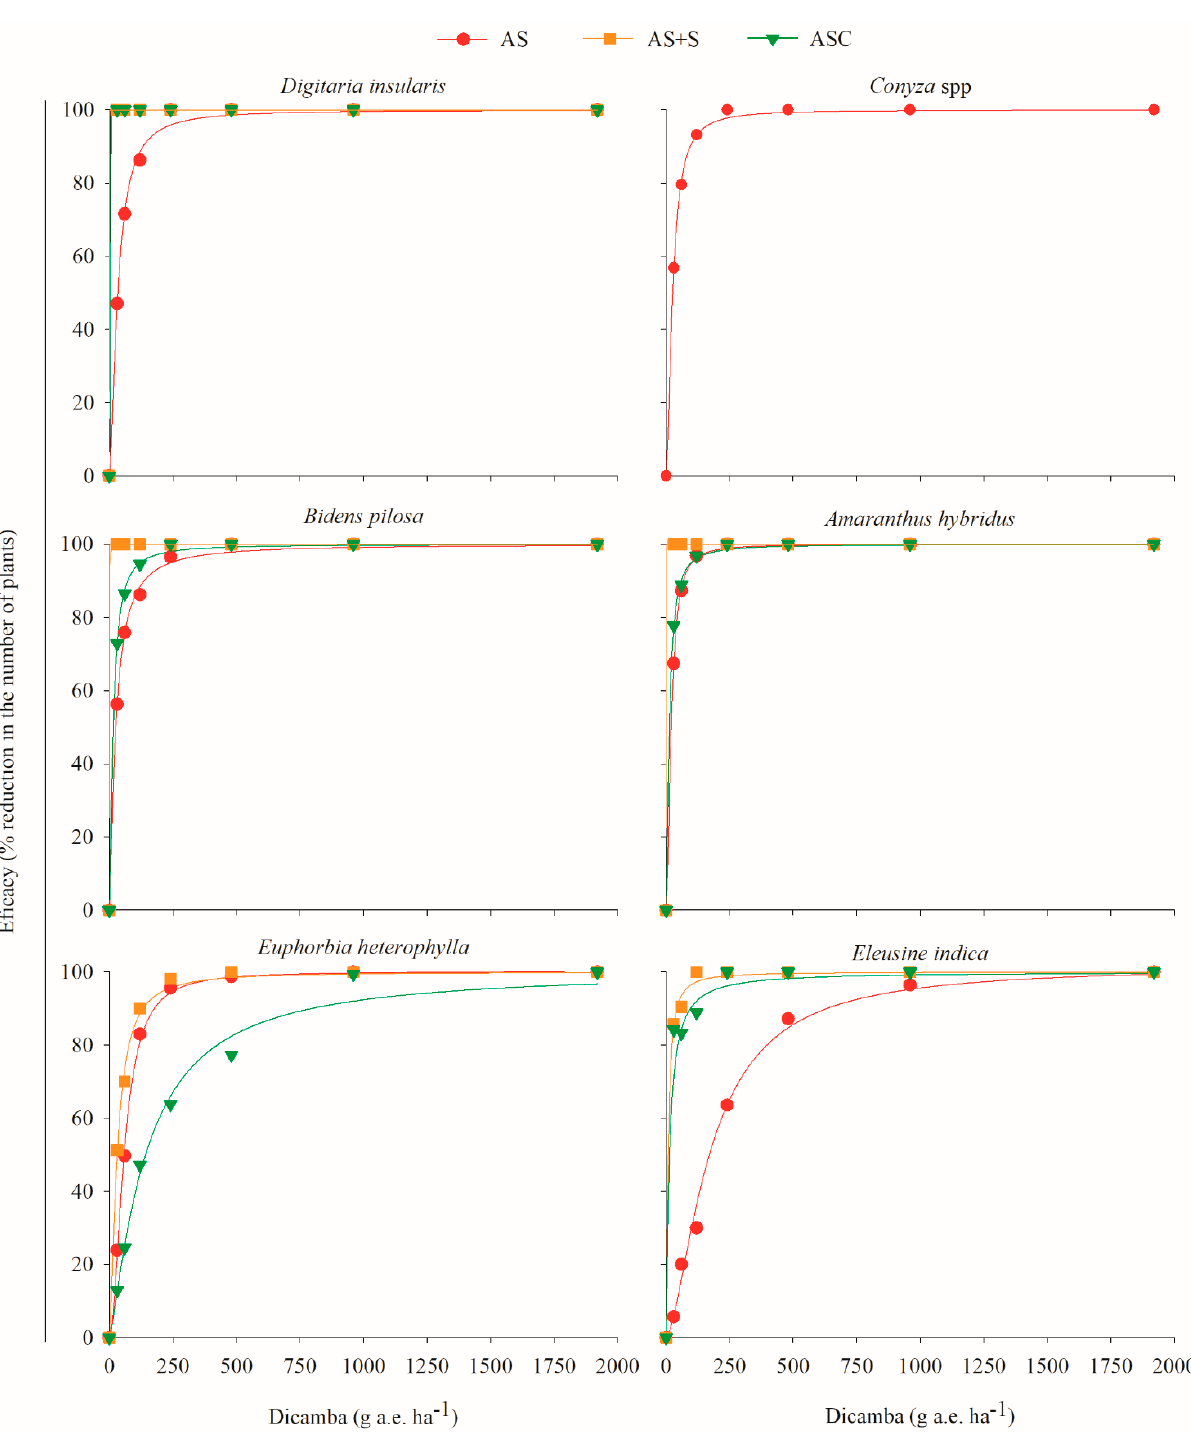
Figure 4. Efficacy of dicamba salt DGA in the pre-emergence of Digitaria insularis, Conyza spp ., Bidens pilosa, Amaranthus hybridus, Euphorbia heterophylla , and Eleusine indica as a function of the application method. AS = application of dicamba directly on the soil without subsequent straw cover; AS + S = application of dicamba on the soil followed by straw cover; ASC = application of dicamba on the straw covering the soil. All were followed by a simulation of 10 mm of rain. The data are expressed as the percentage of the reduction in the number of plants in relation to the treatment with no applied herbicide for each application type.